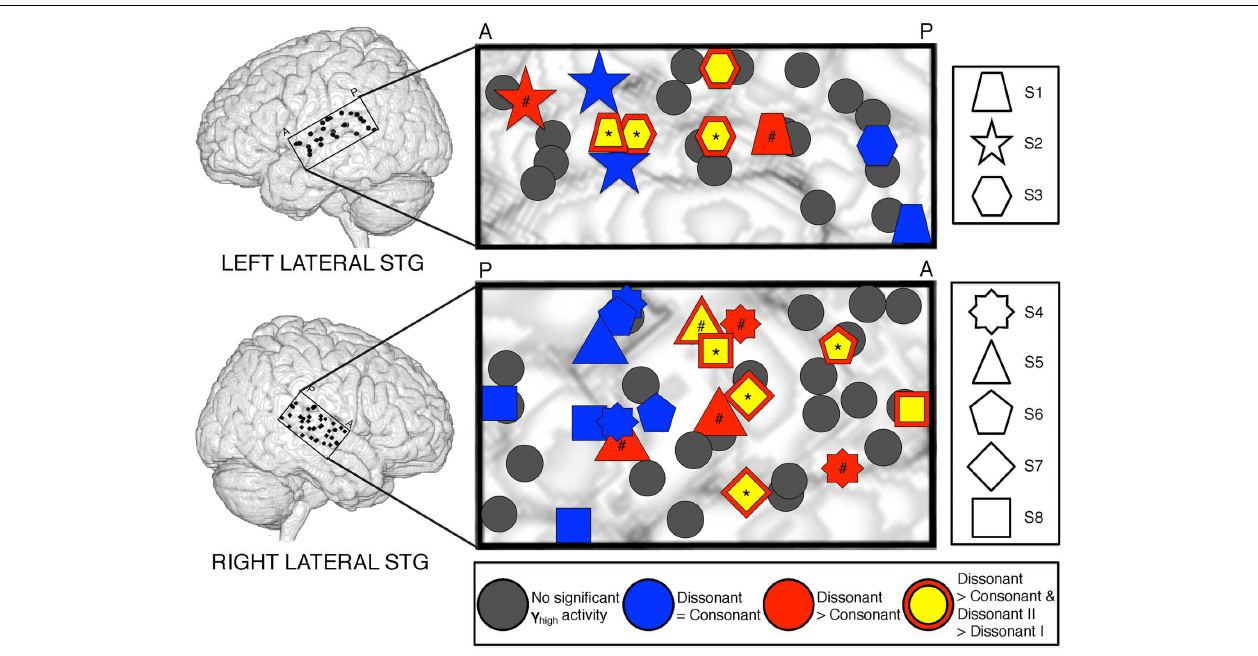
FIGURE 2 | Spatial distribution of electrodes with differential responses to consonant and dissonant chords in left and right lateral STG. Electrodes located within the STG for all subjects are shown superimposed on a model brain for each hemisphere. Gray electrodes show minimal or no significant γ high (70–150 Hz) activity in response to any chord type; blue electrodes show no difference in γ high activity between consonant and dissonant chords (Wilcoxon rank-sum, p > 0.05); red electrodes show increased γ high activity in response to dissonant chords than consonant chords (Wilcoxon rank-sum, p < 0.05); yellow electrodes with a red border show greater γ high activity in response to dissonant type II chords than dissonant type I chords (Wilcoxon rank-sum, p < 0.05). Significant electrodes in both Dissonant > Consonant and Dissonant II > Dissonant I conditions after FDR multiple comparisons correction of q = 0.05 are marked with a ∗ , and significant electrodes in only the Dissonant > Consonant condition are marked with a #. Onset and duration of FDR-corrected significant increases in γ high activity vary per electrode and is detailed in Table 2 . Each shape denotes an individual subject. P – posterior, A –